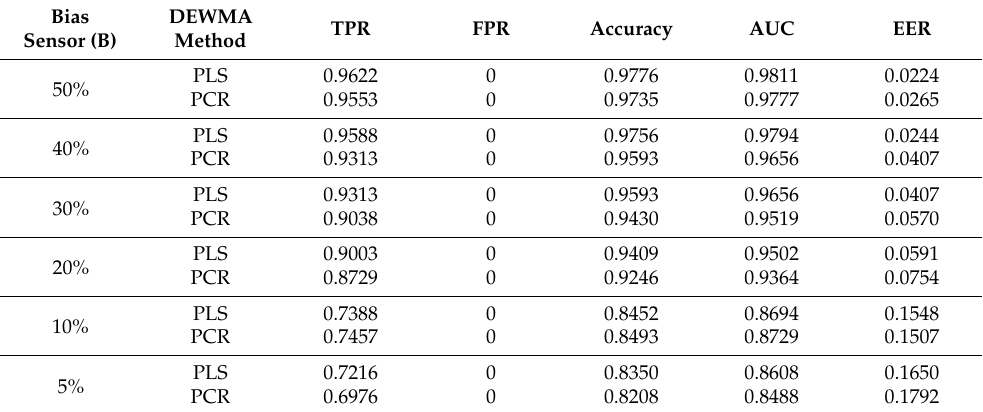
Table 8. Results of PLS- and PCR-based DEWMA charts under bias sensors fault in pyranometer.